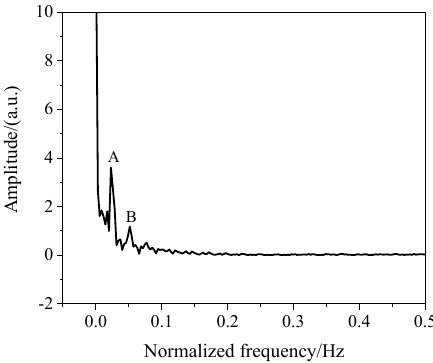
Figure 6. The Fast Fourier Transform